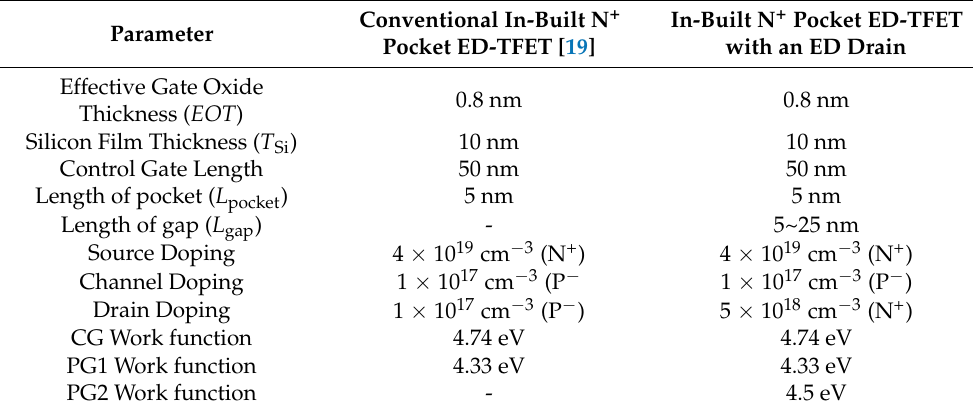
In-Built N + Pocket